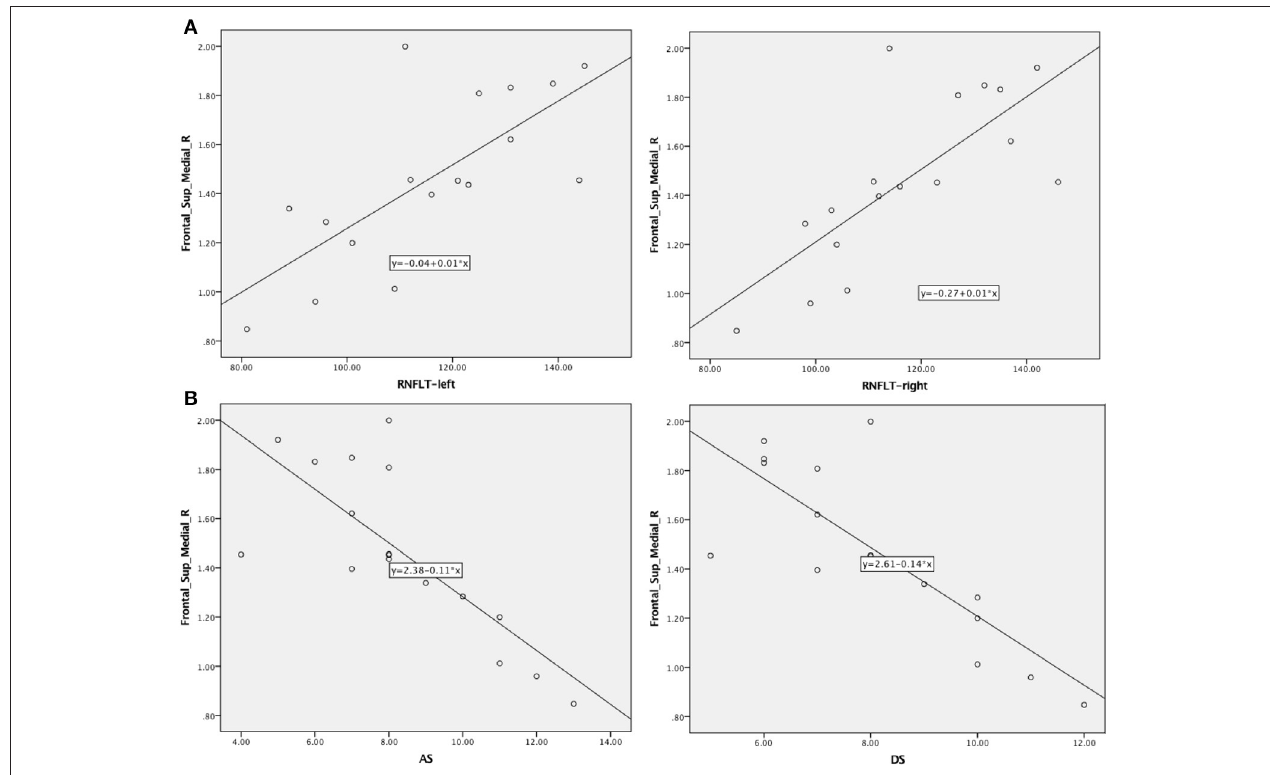
FIGURE 4 | Correlations between AS/DS and RNFLT and the PerAF signal intensity in patients with MMD. (A) Negative associations were found between the AS/DS and the PerAF value in the Frontal_Sup_Medial_R. (B) Positive associations were found between left-RNFLT, right-RNFLT, and the PerAF value in Frontal_Sup_Medial_R. AS, anxiety score; DS, depression score; RNFLT, retinal nerve fiber layer thickness; PerAF, percent amplitude of fluctuation.